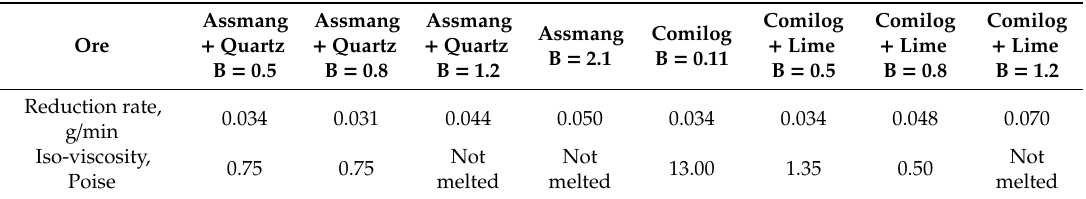
Table 6. Parameters for kinetic